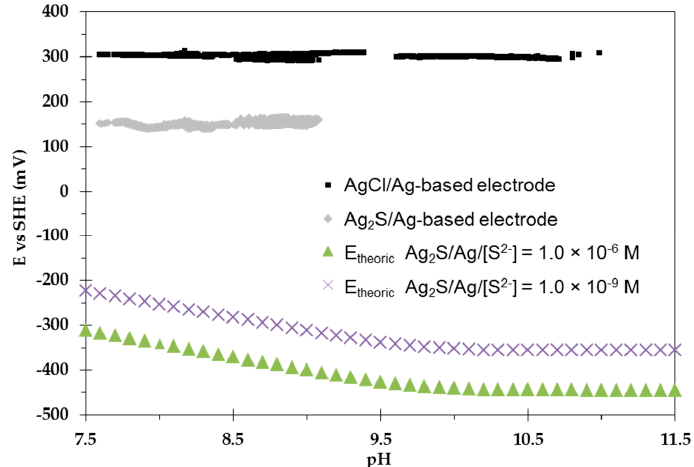
Figure 11. Eh-pH diagram of both AgCl/Ag- and Ag 2 S/Ag-based electrodes. Experiments were done in the reconstituted COx solution at 25 ◦ C, in the glove box. NaOH was used to increase pH. Theoretical Eh-pH variation curves of the Ag 2 S/Ag-based electrode in the presence of [S 2 − ] at total concentrations of 1.0 × 10 − 6 M and 1.0 × 10 − 9 M were added for